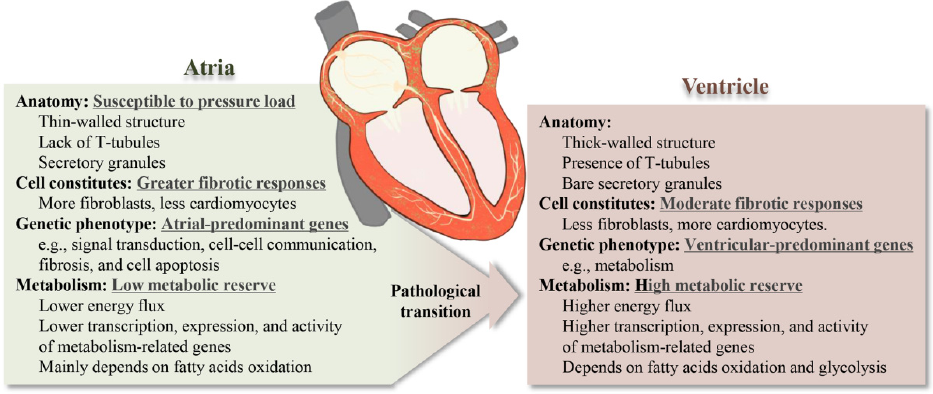
Figure 1. Metabolism in the healthy atrium.